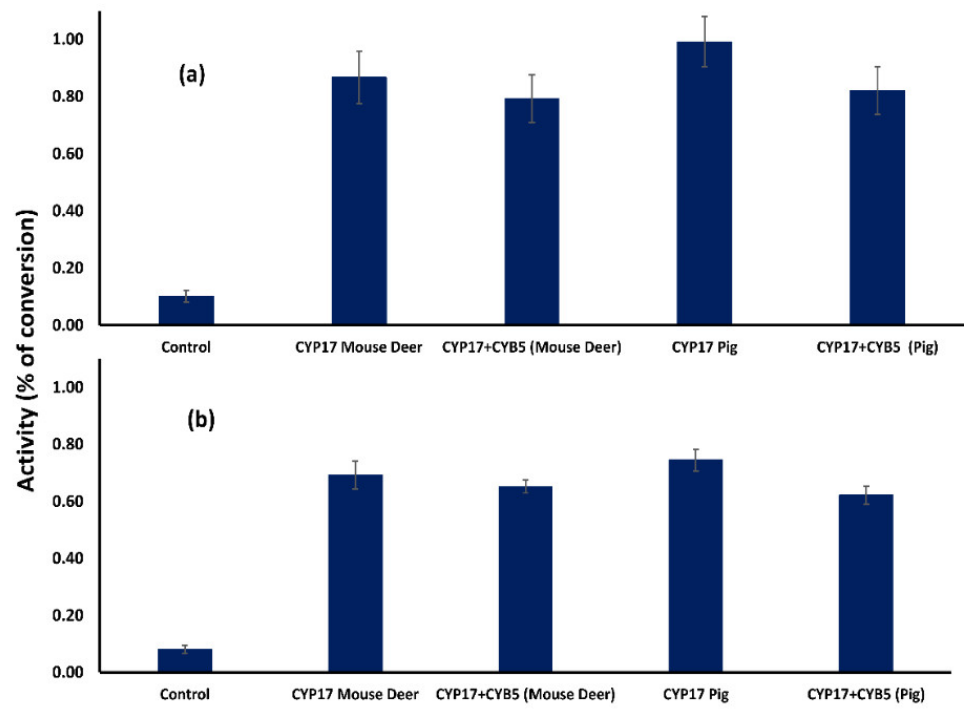
Figure 5. Transformation of 5,16-androstadien-3β-ol from pregnenolone by mouse deer and pig CYP17A1 and effect of CYB5A in combination with CYP17A1 in ( a ) HEK-293 and ( b ) COS-7 cells. The results are the mean ± SEM of three independent experiments. An empty vector was used as a